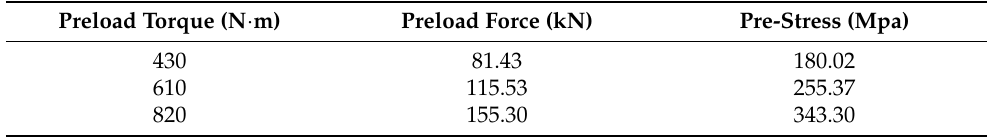
Table 3. Preload torque, preload force, and prestress values obtained from standard calculations.